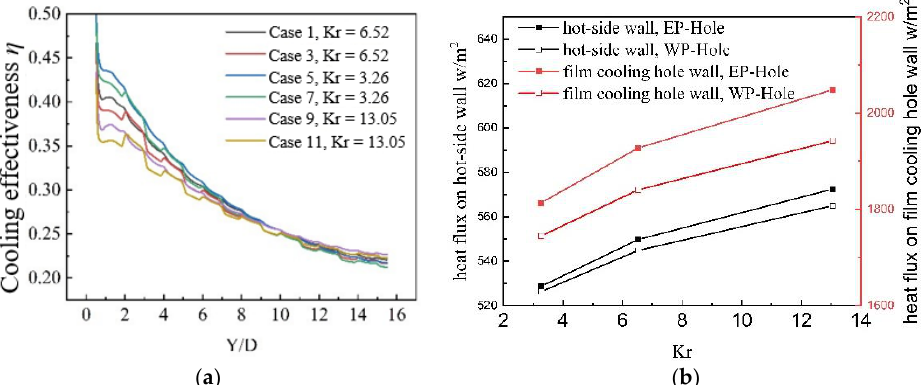
Figure 15. Cooling efficiencies and heat flux: ( a ) cooling efficiencies of line 1 with different Kr, and ( b ) heat flux on hot-side wall and film-cooling hole wall of EP-Hole and WP-Hole with different Kr.